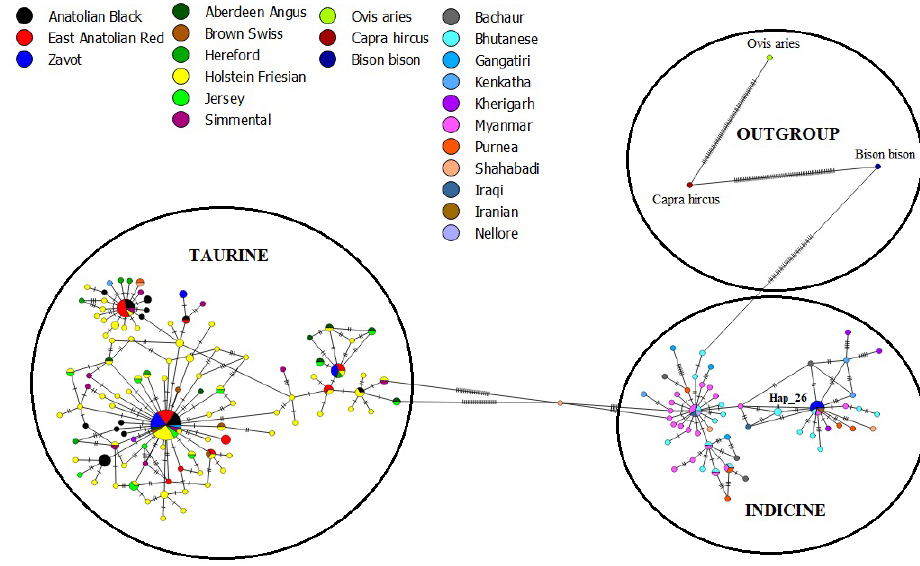
Figure 4. Median joining network of sequences from NCBI database (taurine, indicine and outgroup species) and three native Turkish cattle breeds via 450bp mtDNA D-Loop